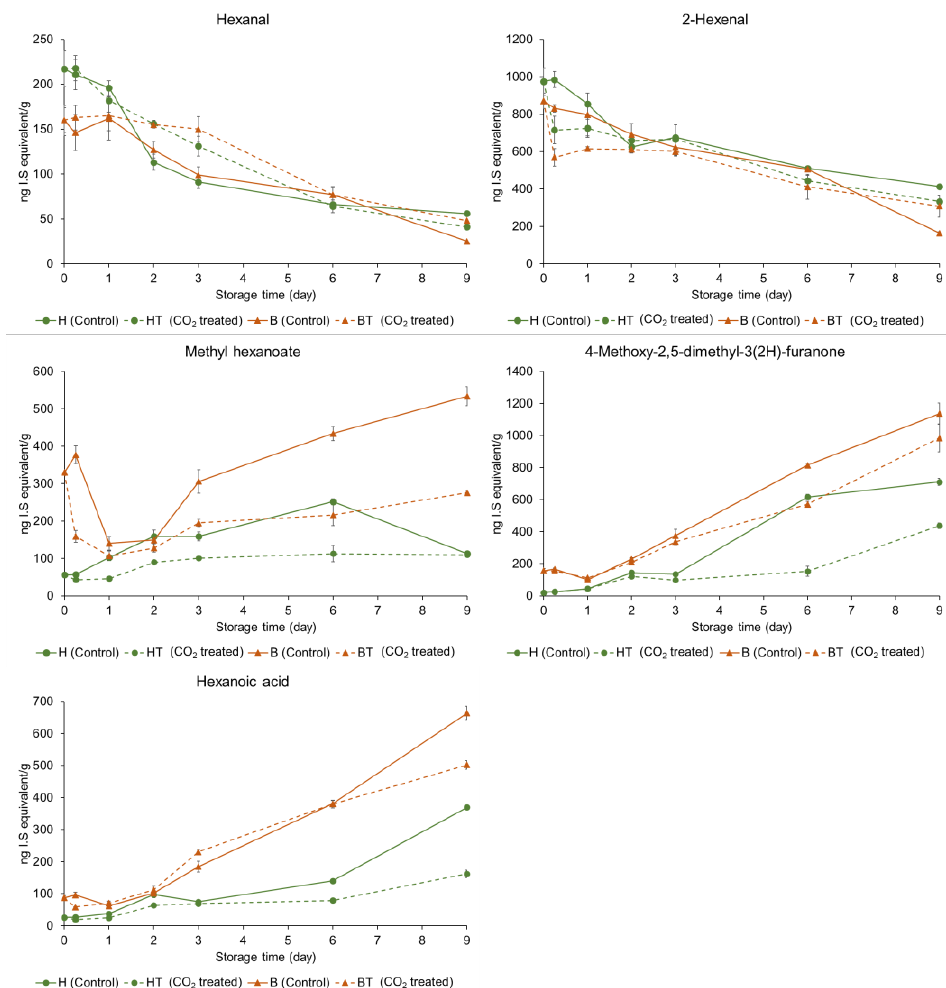
Figure 3. Comparisons of relative concentrations of characteristic volatile compounds in control and CO 2 -treated strawberries at varying stages of ripening stored at 10 °C for 9 d (H: half-red, B: bright-red, T: CO 2 treated, h: hours, D: days). The concentration of each volatile compound was described as the relative concentration of the appropriate internal standard.